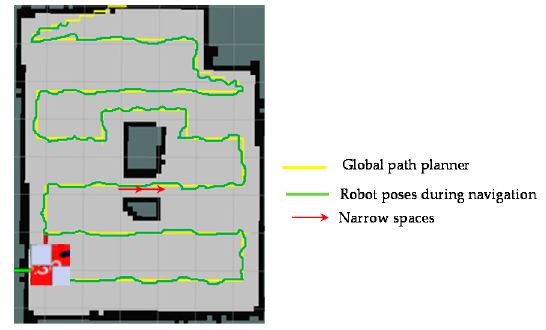
Figure 16. Global path planner and robot pose during navigation.